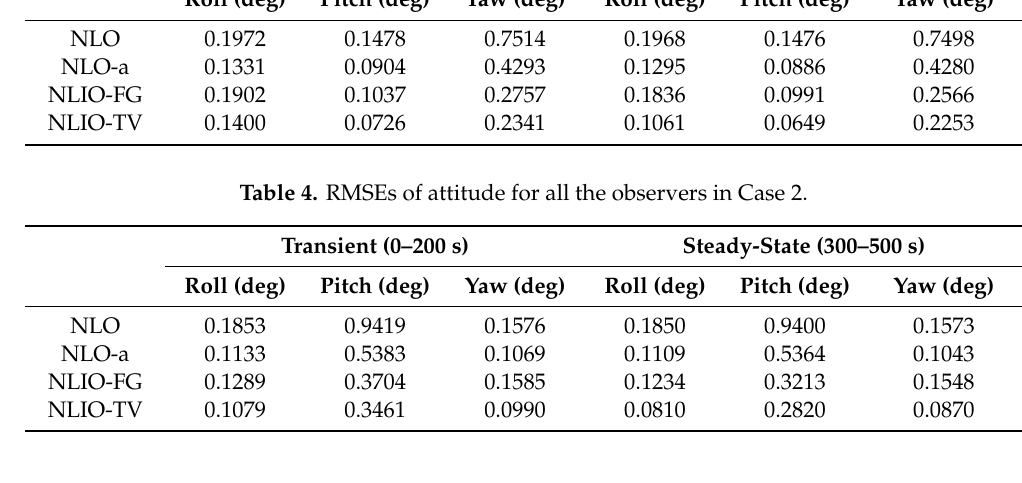
Figure 8. Averaged absolute gyro bias estimation errors over 100 simulations for Case 2.